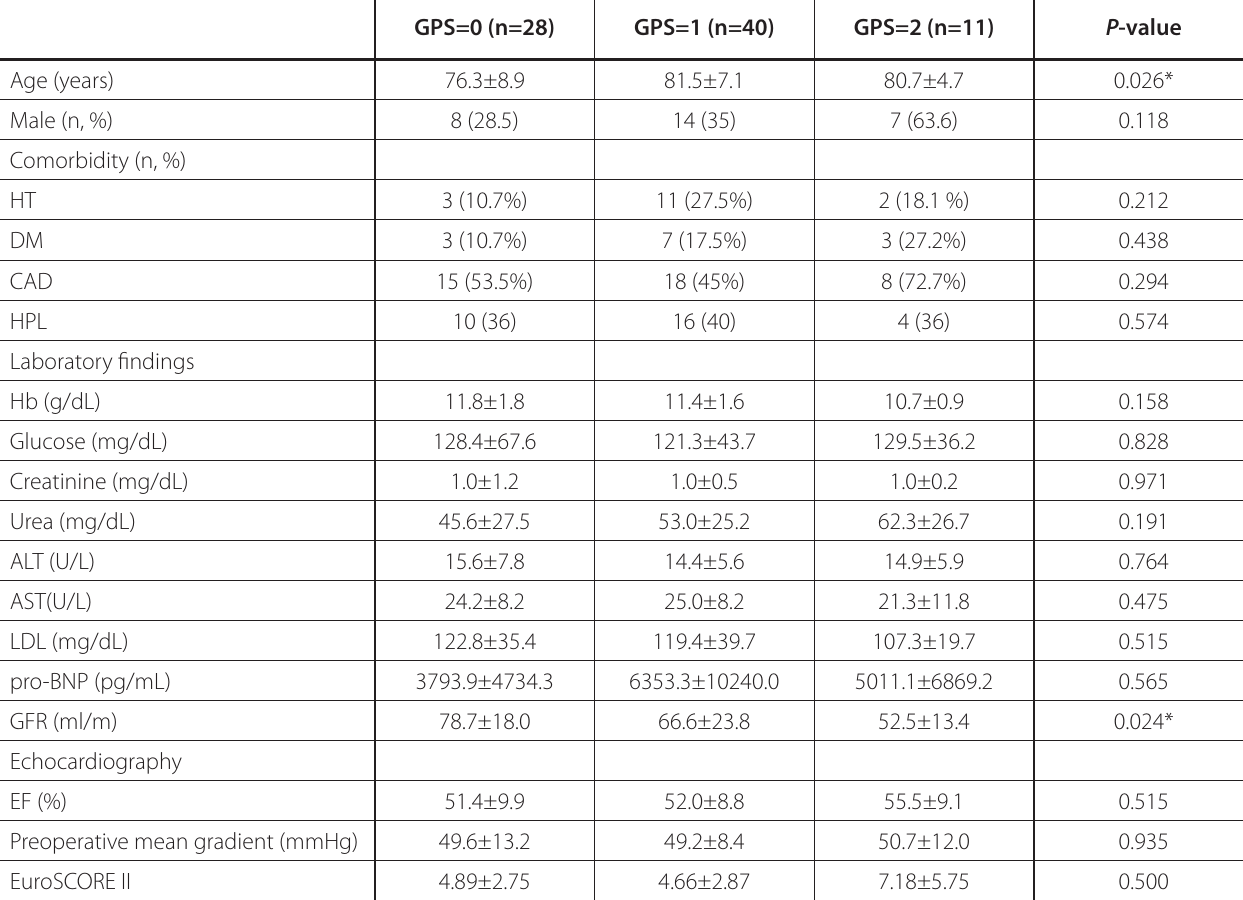
Table 1 . Association of GPS with patients’